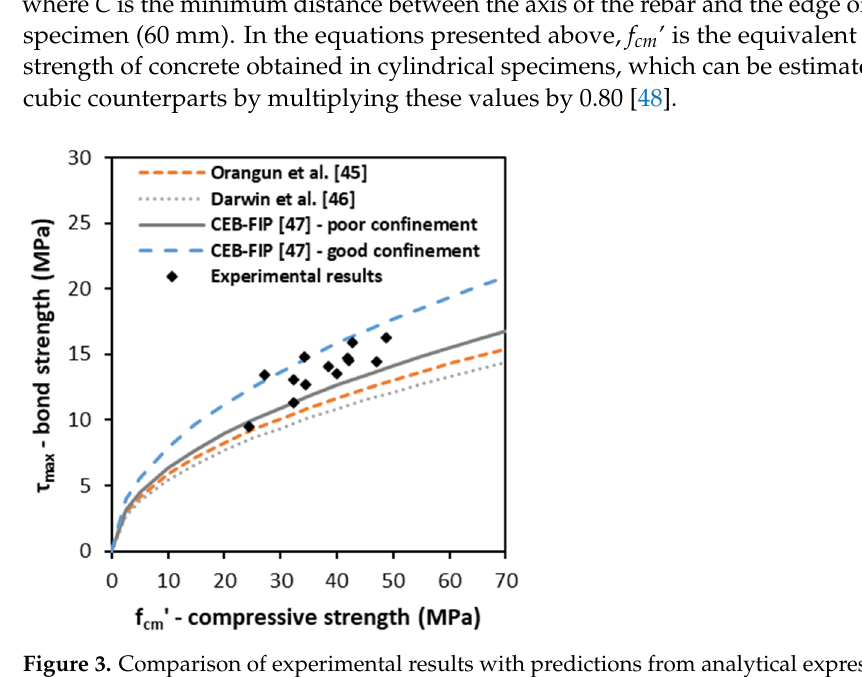
Figure 3. Comparison of experimental results with predictions from analytical